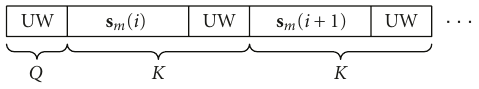
Figure 1: Example of UW block structure for single-carrier sys-